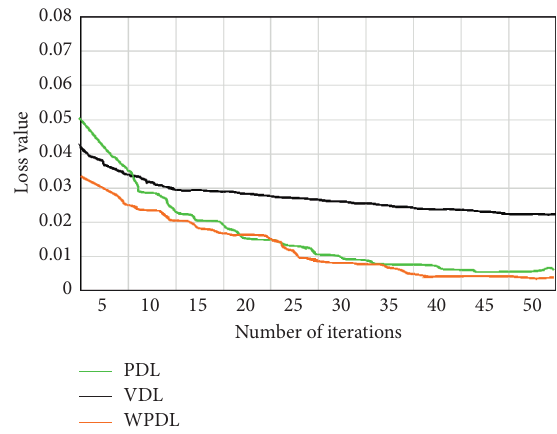
Figure 6: Test errors corresponding to different loss functions.